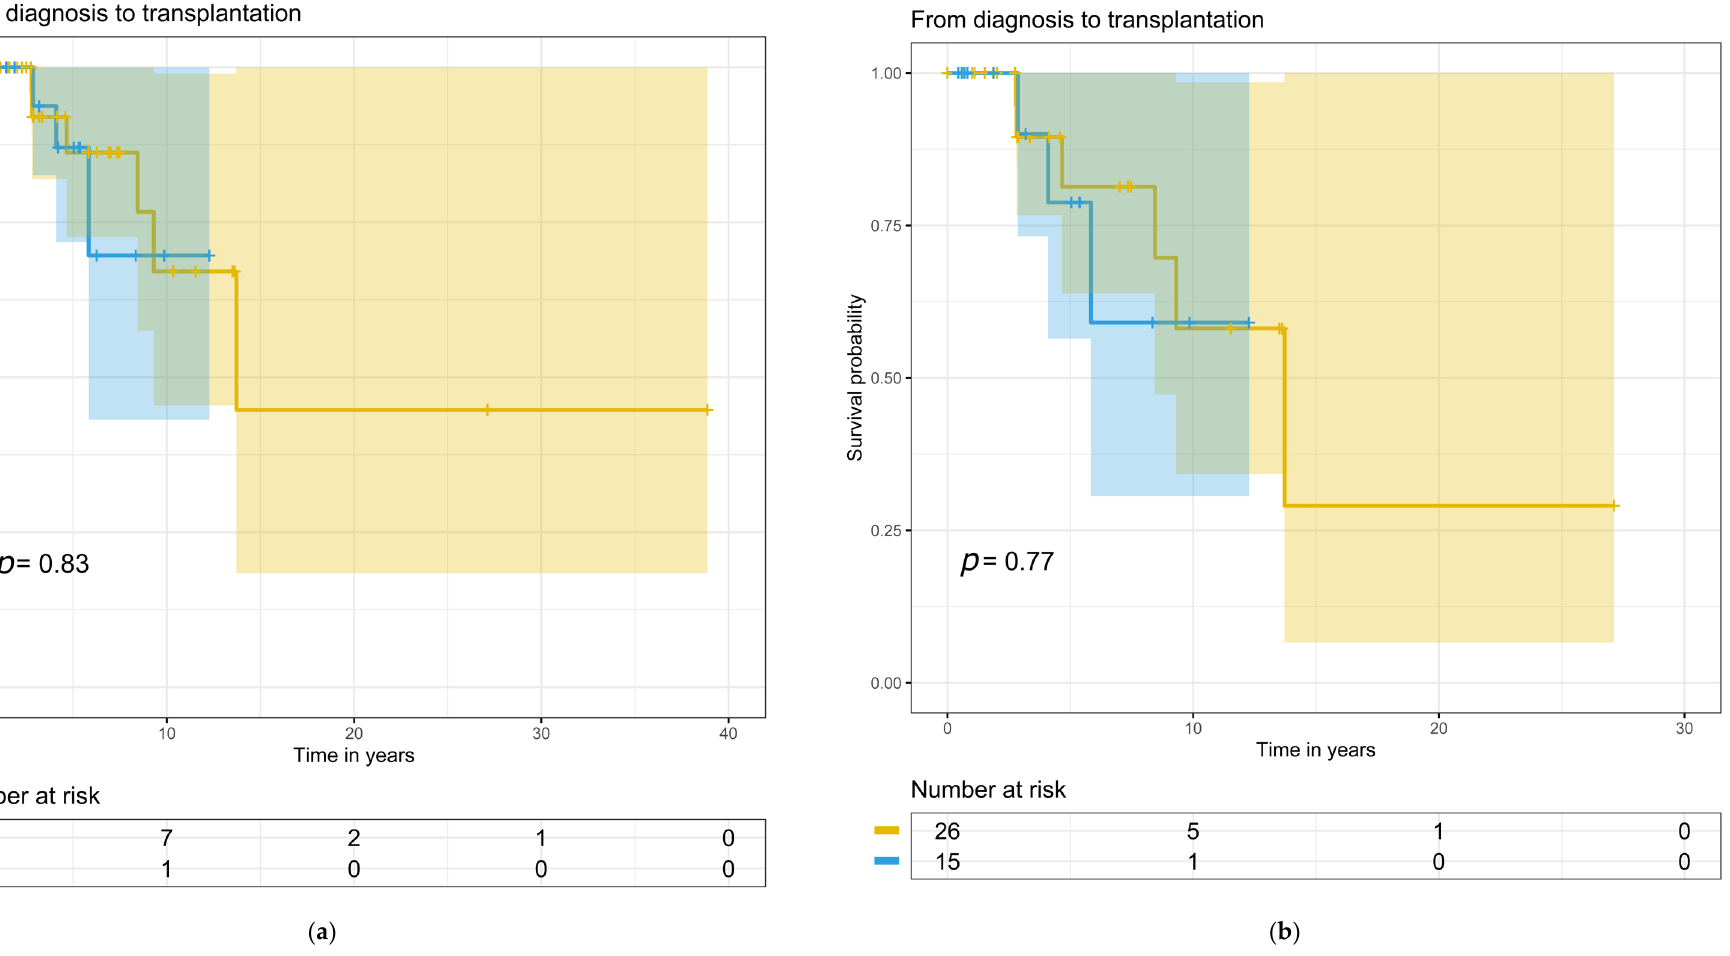
Figure 5. Longitudinal changes from diagnosis to transplantation with numbers at risk: ( a ) for the entire study population; ( b ) for the primary MPGN and C3G cases. The yellow line indicates IC-MPGN and the blue line indicates C3G. Colored areas indicate confidence interval and small vertical lines indicate the end of follow-up.